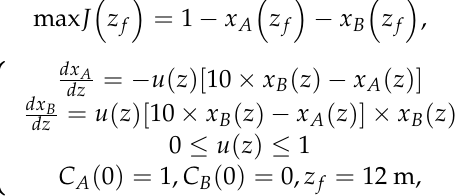
Figure 9. Optimal trajectory of state variables.